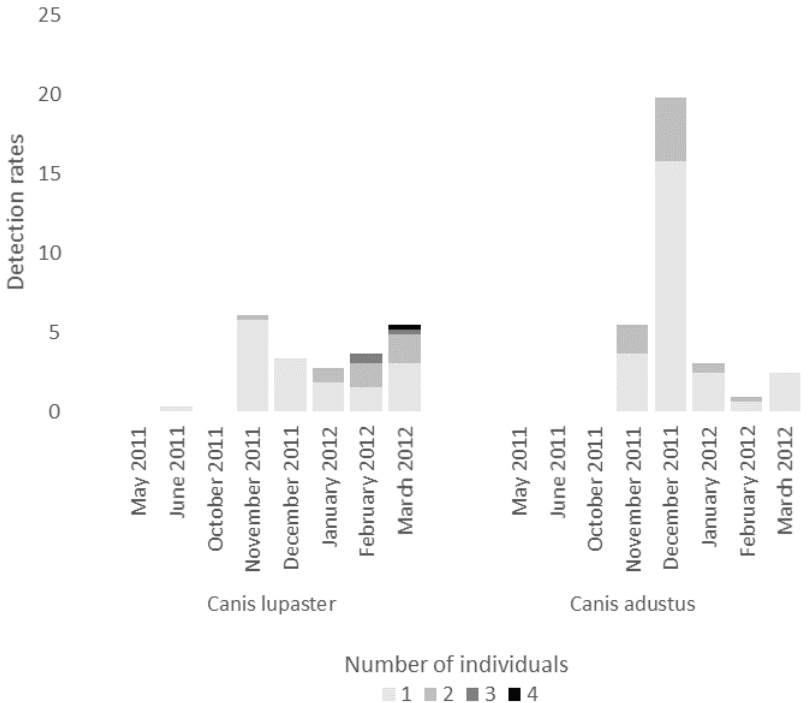
Figure2. TemporalvariationinthenumberofdetectedindividualsforAfricanwolvesandside-stripedjackals, based on detection rates (number of independent records / total trapping effort) per 100 night-traps by camera Figure 2. Temporal variation in the number of detected individuals for African wolves and side- trapping near artificial waterholes in the Ferlo region striped jackals, based on detection rates (number of independent records/total trapping effort) per 100 night-traps by camera trapping near artificial waterholes in the Ferlo region (Senegal).